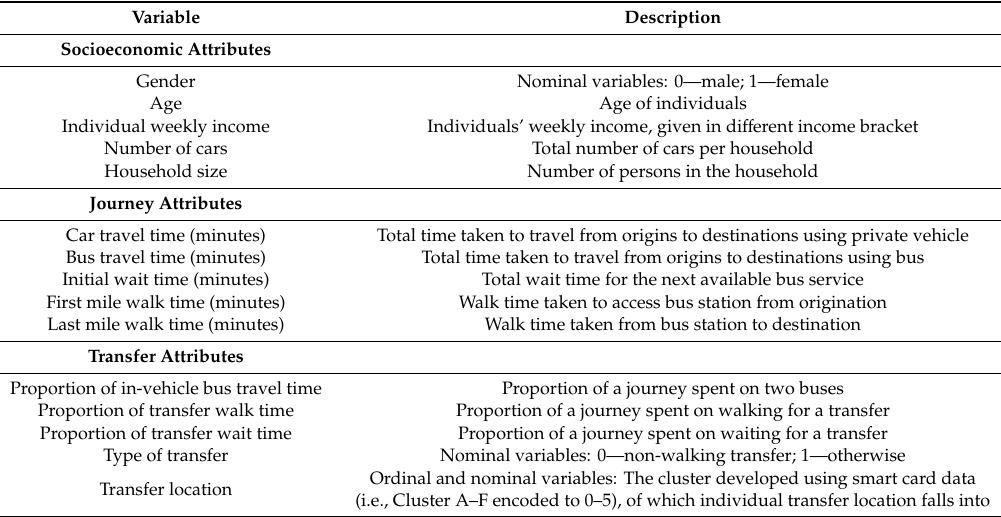
Table 1. List of independent